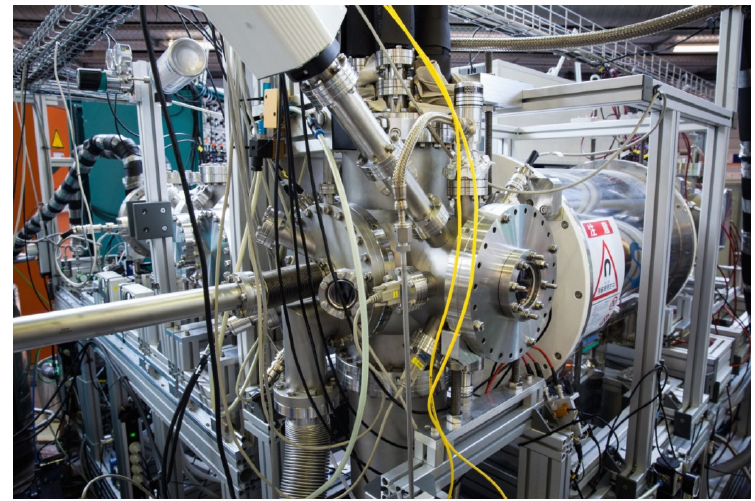
Figure 1: View of the Nanocluster Trap endstation.